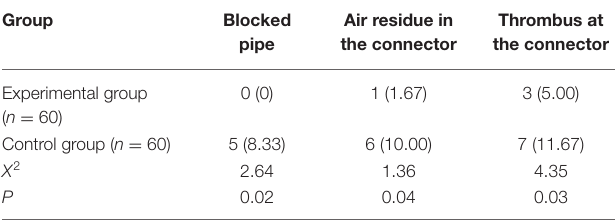
TABLE 3 | Comparison of influencing factors of puncture efficiency [ n (%)].